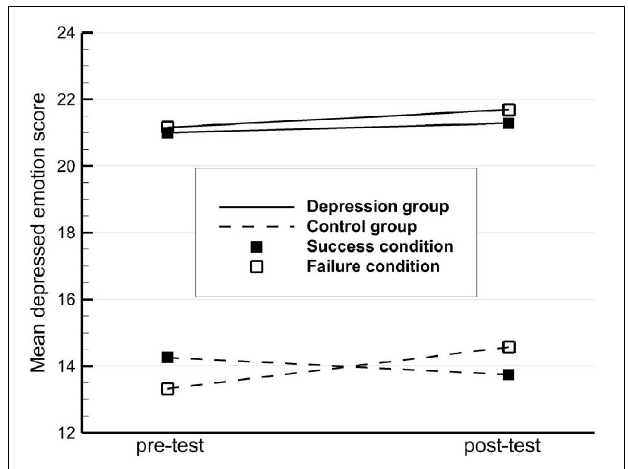
FIGURE 1 | Mean depressed emotion scores by participant type and feedback